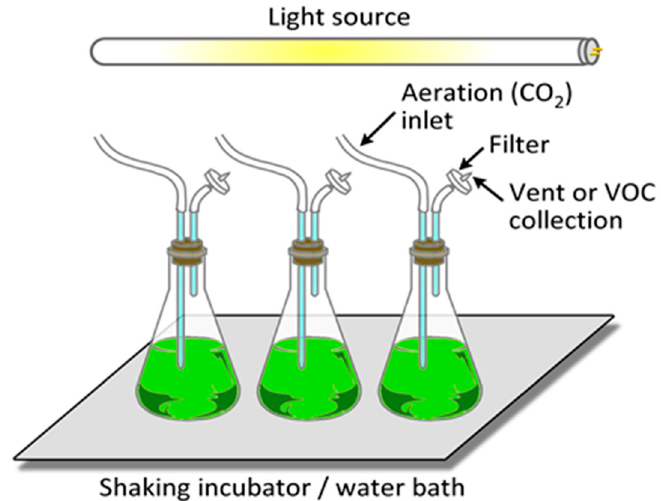
Figure 15. Schematic representation of microalgae culture in the laboratory for collecting VOCs.